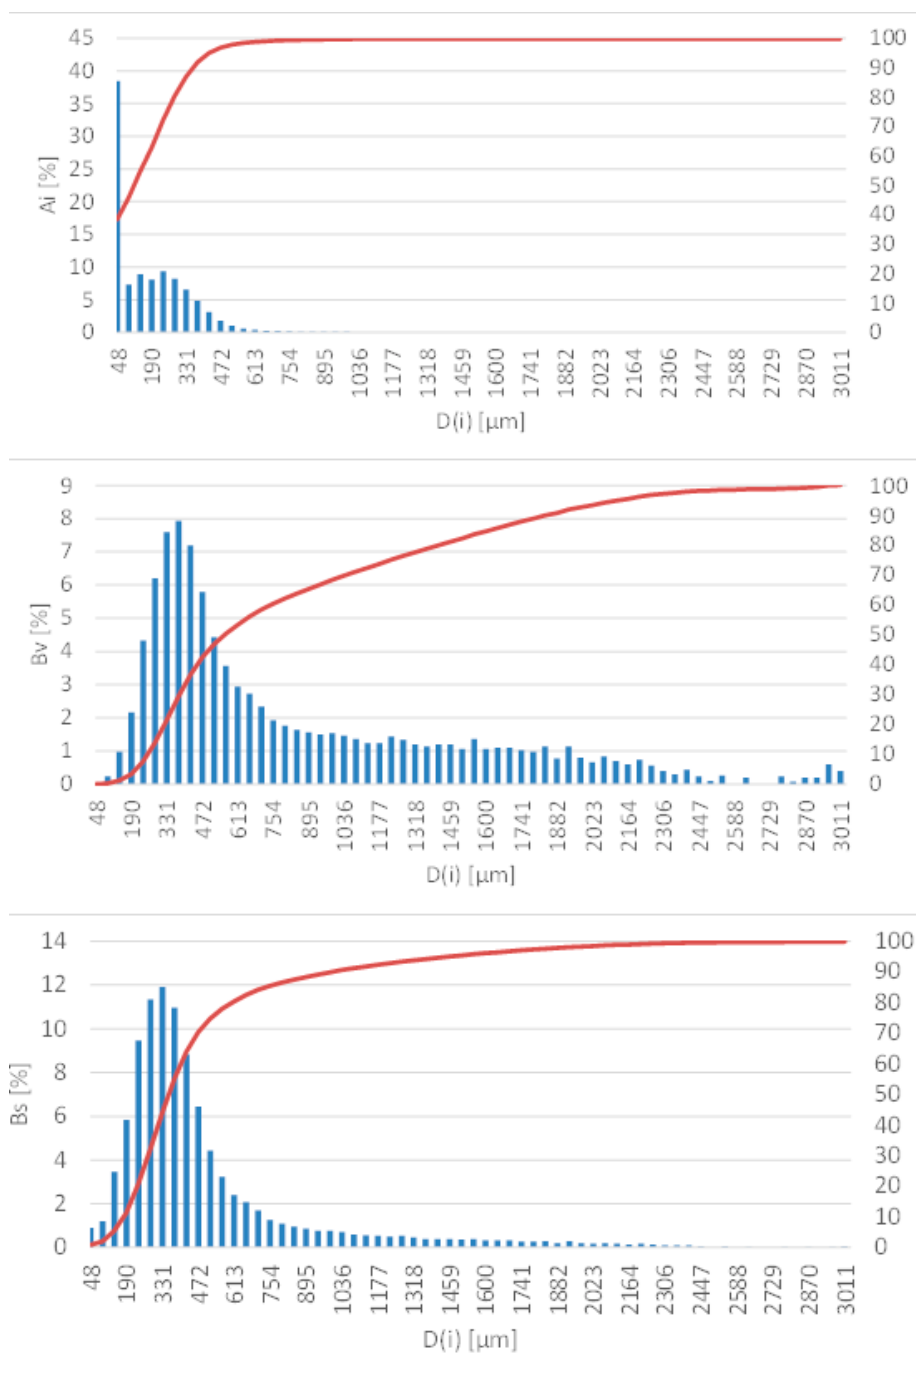
Figure 1. Quantitative (Ai), volumetric (Bv) and area distribution (Bs), A < 2 mm.